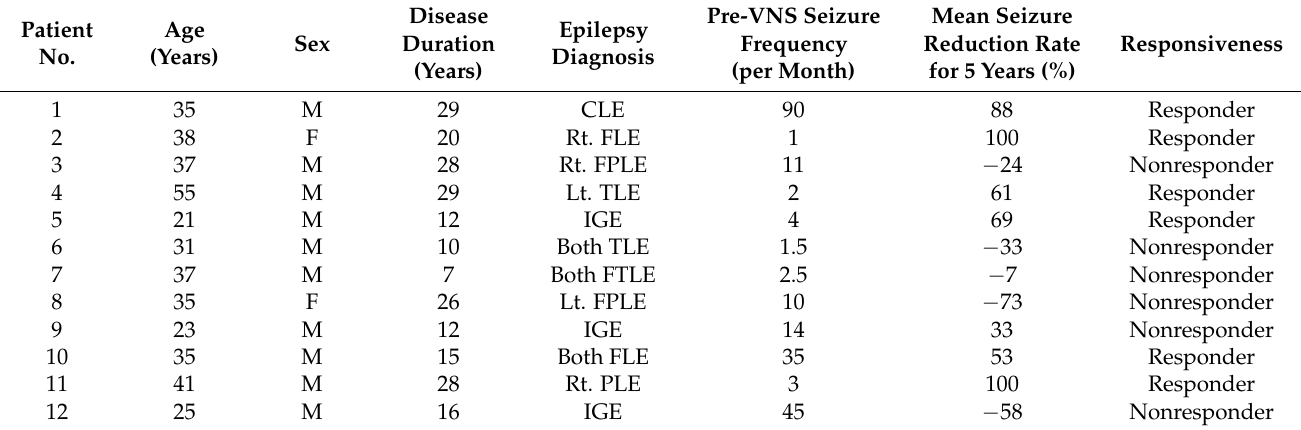
Table 1. Baseline characteristics of the patients enrolled in the